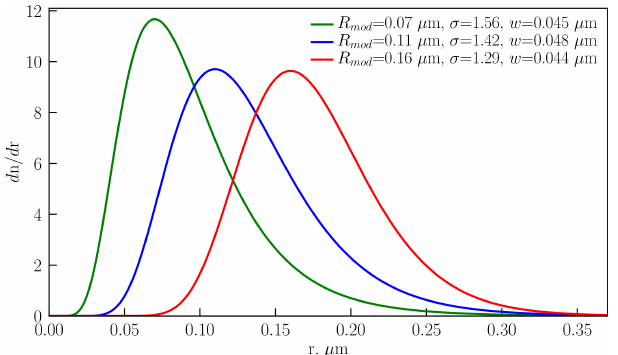
Figure 12. Aerosol particle size distributions with α 750 / 1530 = 3 . 17. For convenience, N = 1cm − 3